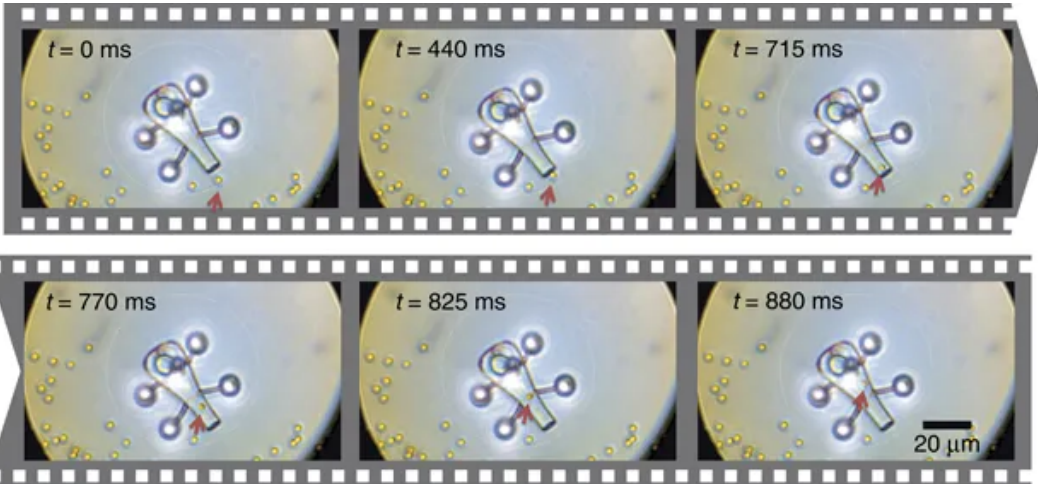
Figure 3. The inclusion of a thin metallic layer inside a 3D printed chamber leads to the movement of silica and polystyrene payload particles through convection. Reproduced from Villangca et al. [128], under Creative Commons license NC ND